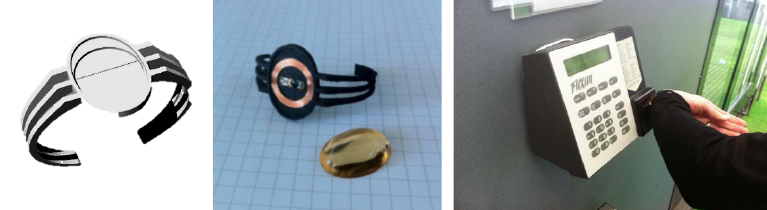
Fig. 9. 3D model, quick prototype and operational testing of the access control